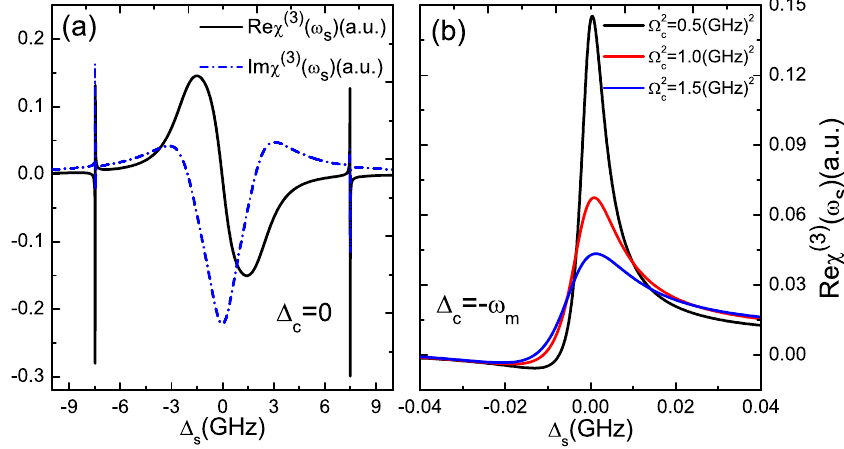
Figure 4. ( a ) The optical Kerr coefficient and nonlinear absorption as functions of ∆ ∆ = 0 ; ( b ) The optical Kerr coefficient as a function of the detuning ∆ c